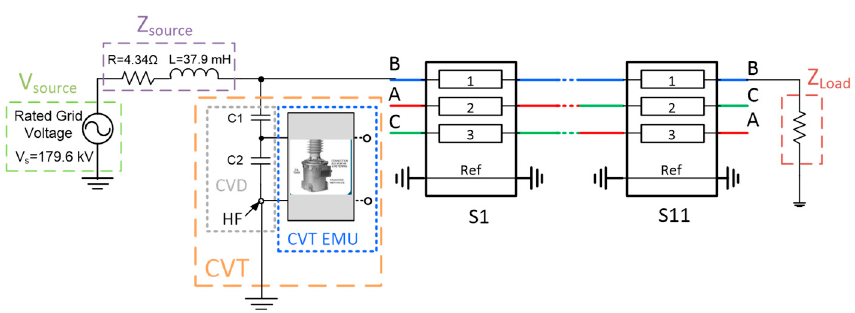
Figure 4. Overall modeling of the in-service line owing to the aim of applying the TDR technique.